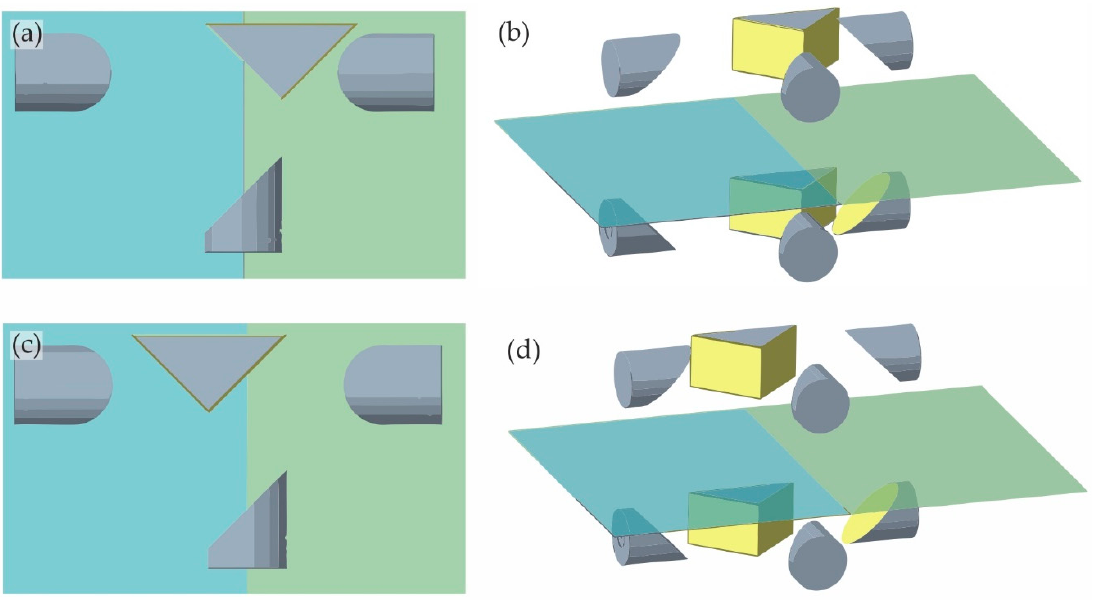
Figure 5. Schematic of the side swap mechanism. ( a , b ) Top view and perspective view of the beam path configuration reaching the left side of the sample, respectively. ( c , d ) Top view and perspective view of the beam path configuration reaching the right side of the sample, respectively.